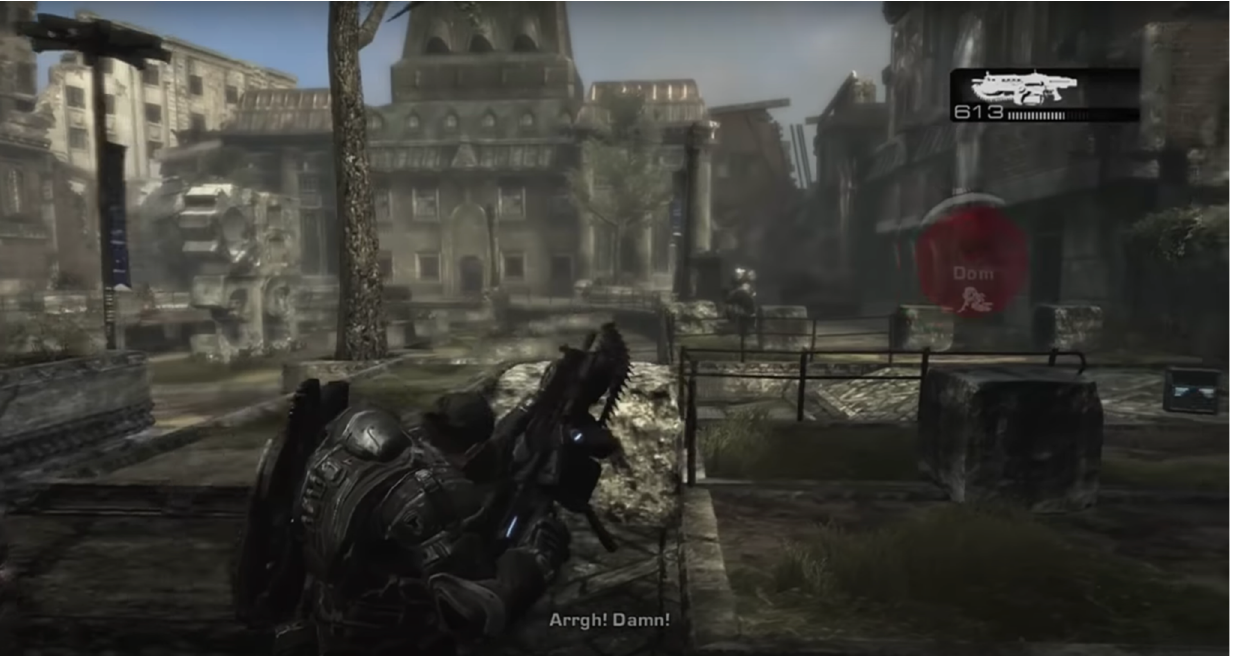
Figure 7. The third-person action-adventure videogame was pioneered by Gears of War (2006). (Screenshot created by author).